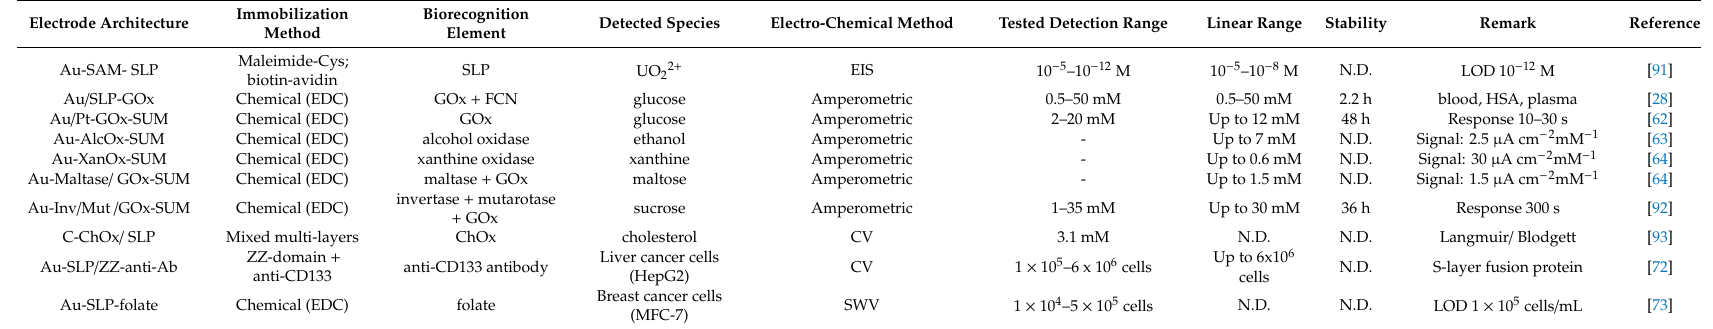
Table 2. Summary of electrochemical biosensors based on S-layer